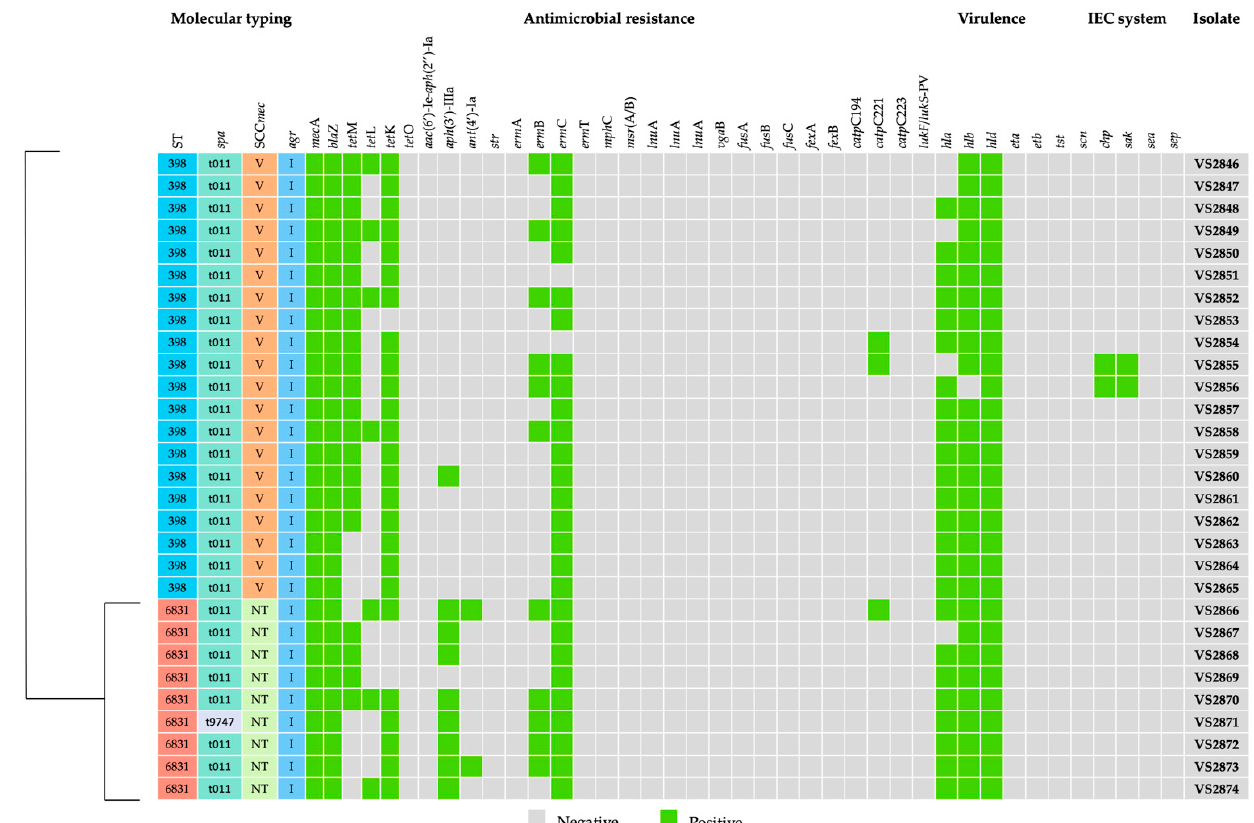
Figure 1. Genotypic profile of antibiotic resistance genes, virulence factors, and genetic diversity detected in each of the 29 LA-MRSA strains isolated from slaughtered for human consumption. ST: sequence type; N.T: Not typeable